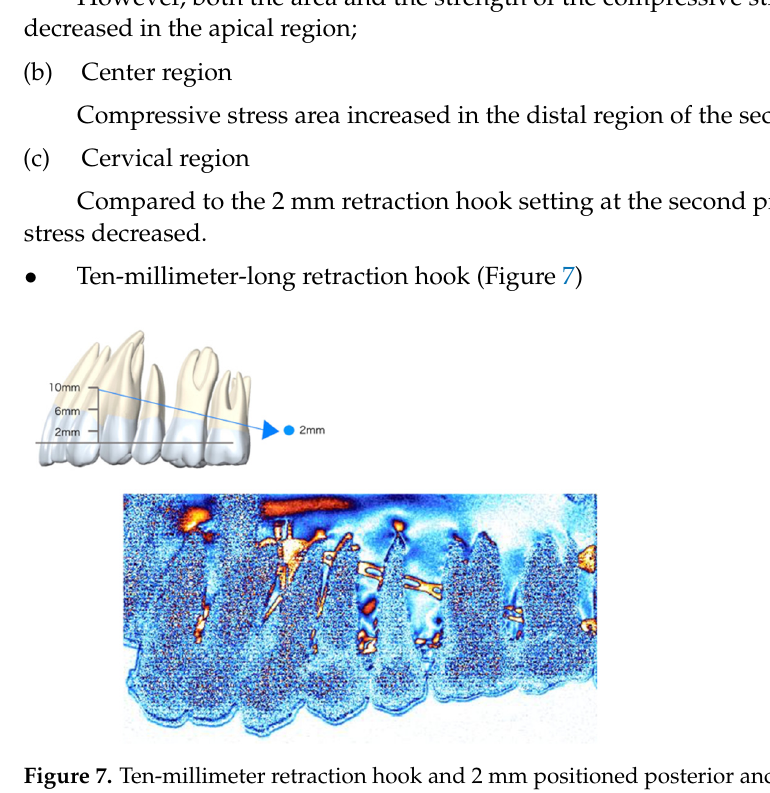
Figure 8. Two-millimeter retraction hook and 8 mm positioned posterior anchor mode. • Six-millimeter-long retraction hook (Figure 9) (a) Apical region Compressive stress in the lateral segment of dentition was observed; however, the forces decreased compared to the 2 mm length of the retraction hook setting; (b) Center region